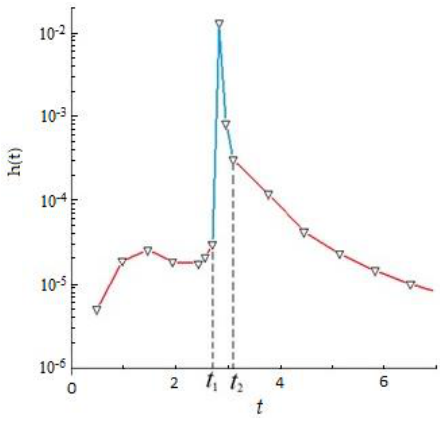
Figure 3. Example of the impulse response simulated by the Monte Carlo method.